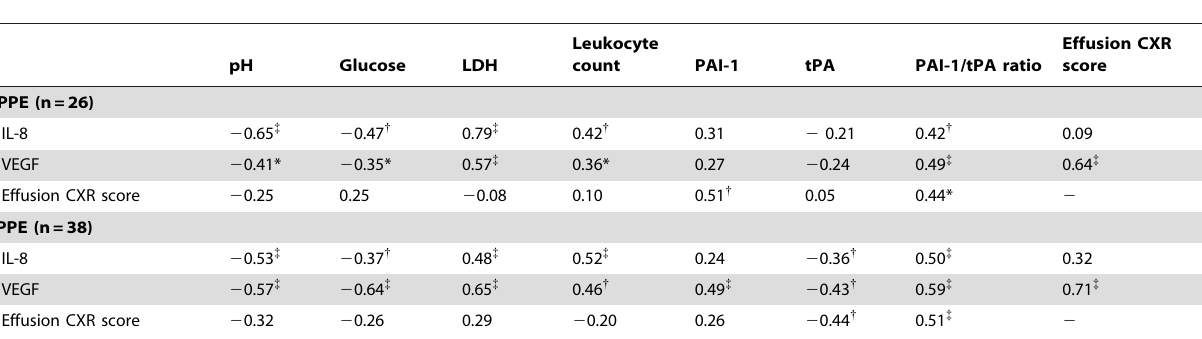
Table 4. Correlation among Angiogenic Cytokines, Fibrinolytic Parameters, Pleural Fluid Characteristics and Effusion CXR